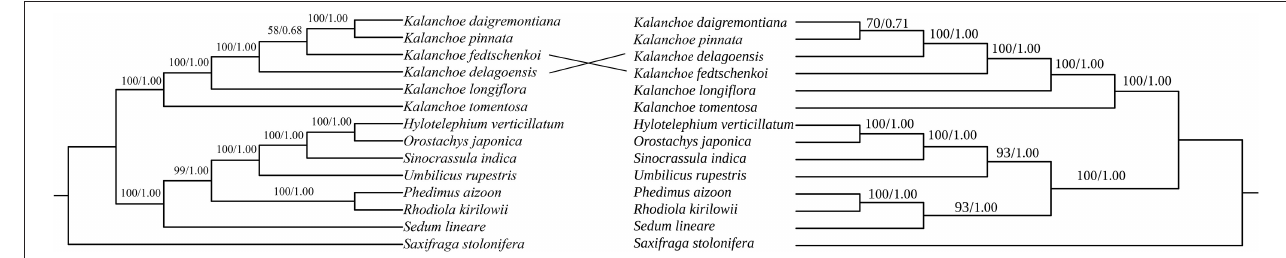
FIGURE 6 | Phylogenetic reconstruction of the Kalanchoe genus using the Complete chloroplast genome sequences (left; A ) and PCQ sequences (right; B ) data with Saxifraga stolonifera as the outgroup for rooting. Bootstrap value/posterior probability are shown on the corresponding branch.